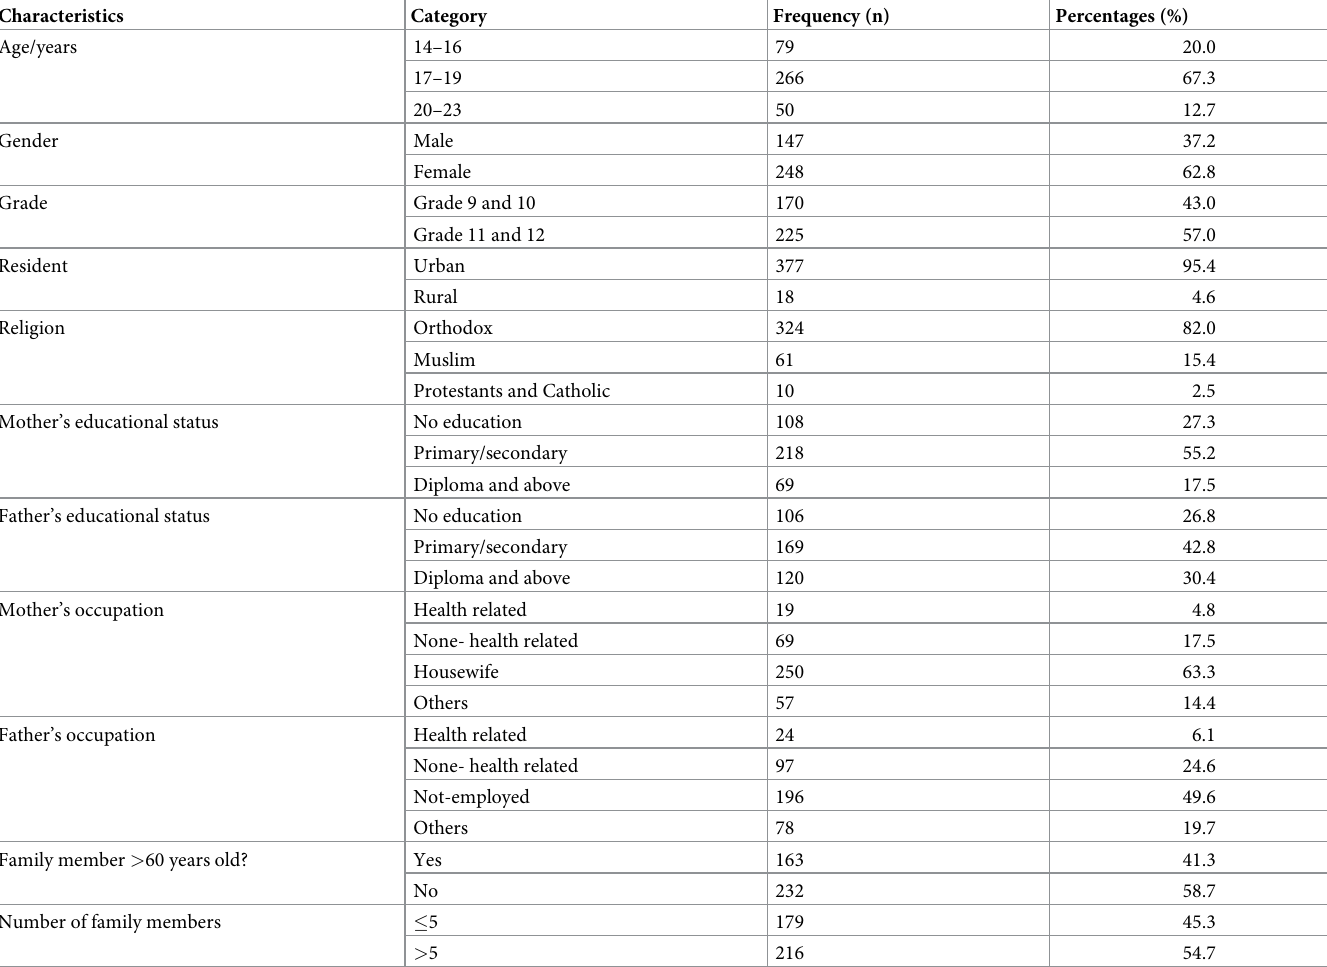
Table 1. Socio-demographic characteristics of secondary school students in Gondar town, Northwest Ethiopia, 2021.